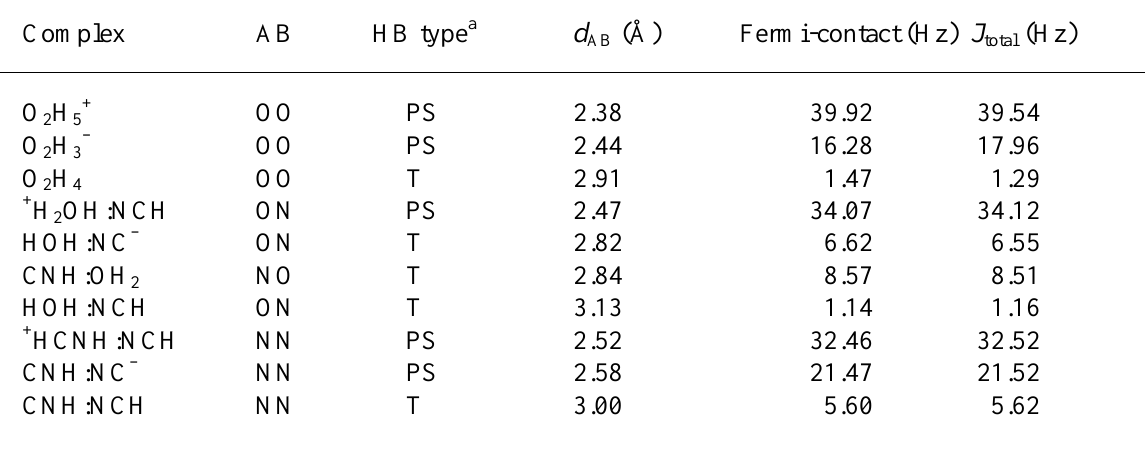
Table 2 . NMR total and FC coupling constants (Hz) for A–H–B